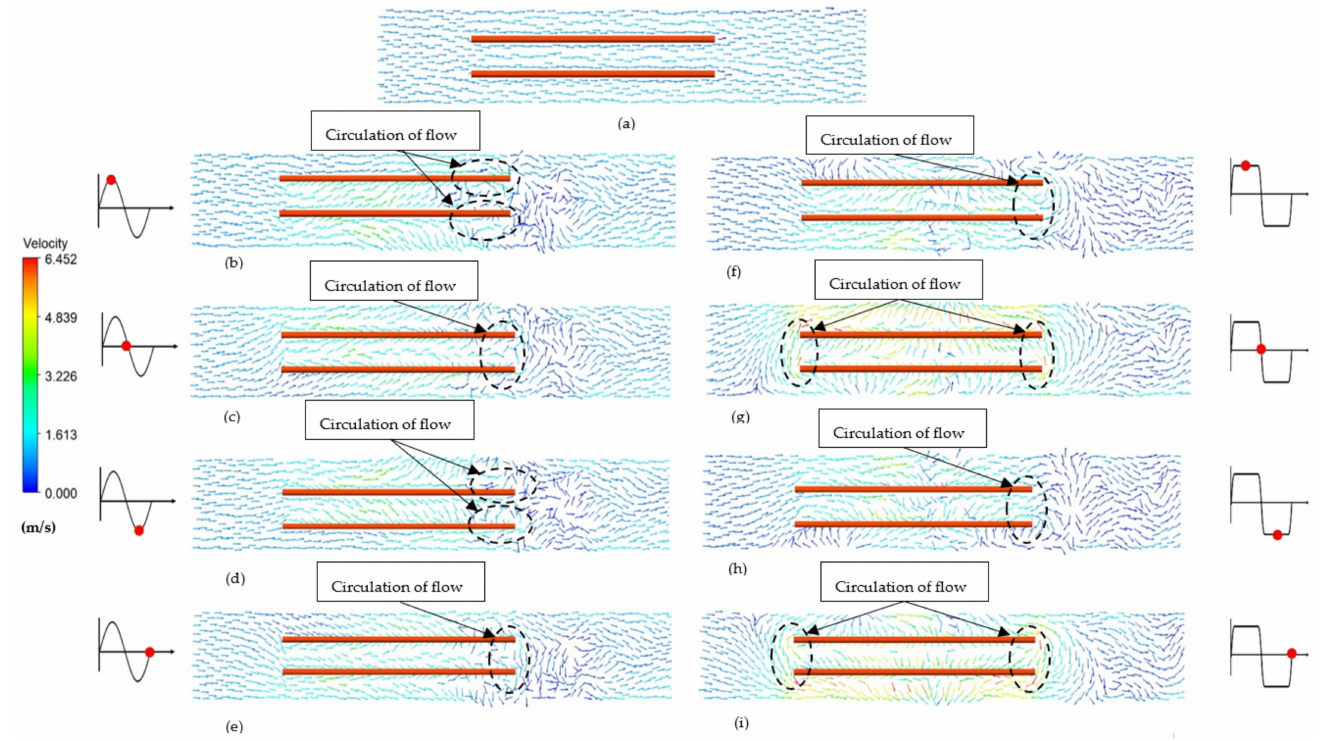
Figure 8. Velocity vectors in the vicinity of the vibrating heat sink at different phases of a cycle of sinusoidal and square wave-shaped vibration at f = 100 Hz, Amp = 0.003 m, and Re = 1000 ( a ) without vibration, ( b ) sinusoidal at 1st quarter of the cycle, ( c ) sinusoidal at 2nd quarter of the cycle, ( d ) sinusoidal at 3rd quarter of the cycle, ( e ) sinusoidal at 4th quarter of the cycle, ( f ) square at 1st quarter of the cycle, ( g ) square at 2nd quarter of the cycle, ( h ) square at 3rd quarter of the cycle, and ( i ) square at 4th quarter of the